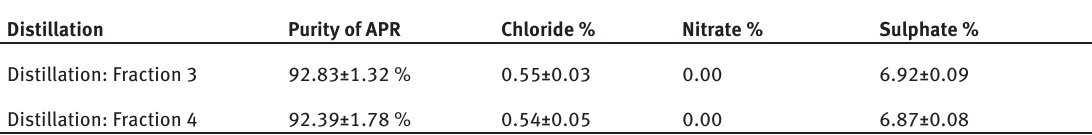
Table 3: Ion chromatography results for an example distillation result for fractions 3 and 4.